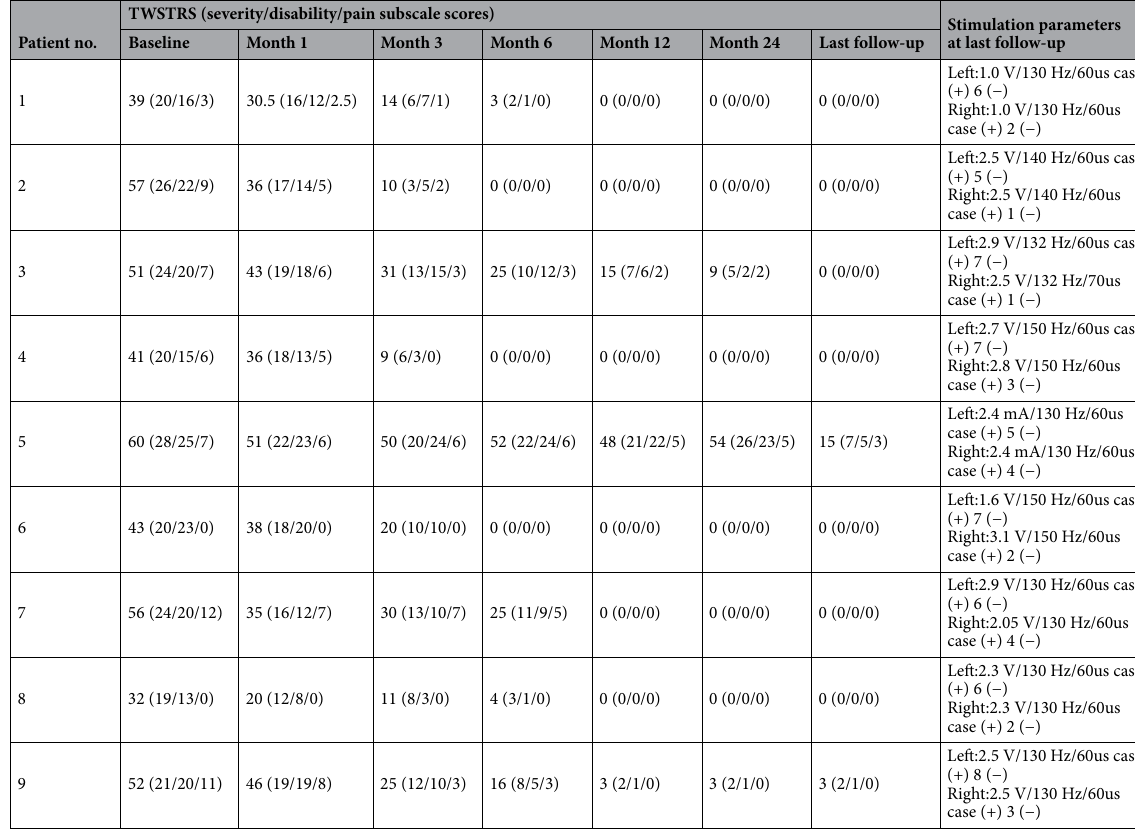
Table 2. TWSTRS scores at baseline and after bilateral STN DBS. TWSTRS Toronto Western Spasmodic Torticollis Rating Scale, STN subthalamic nucleus, DBS deep brain stimulation.